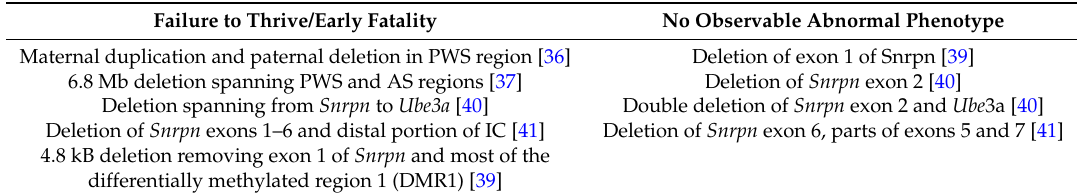
Table 3. Phenotypic characteristics of chromosomal deletion mouse models of